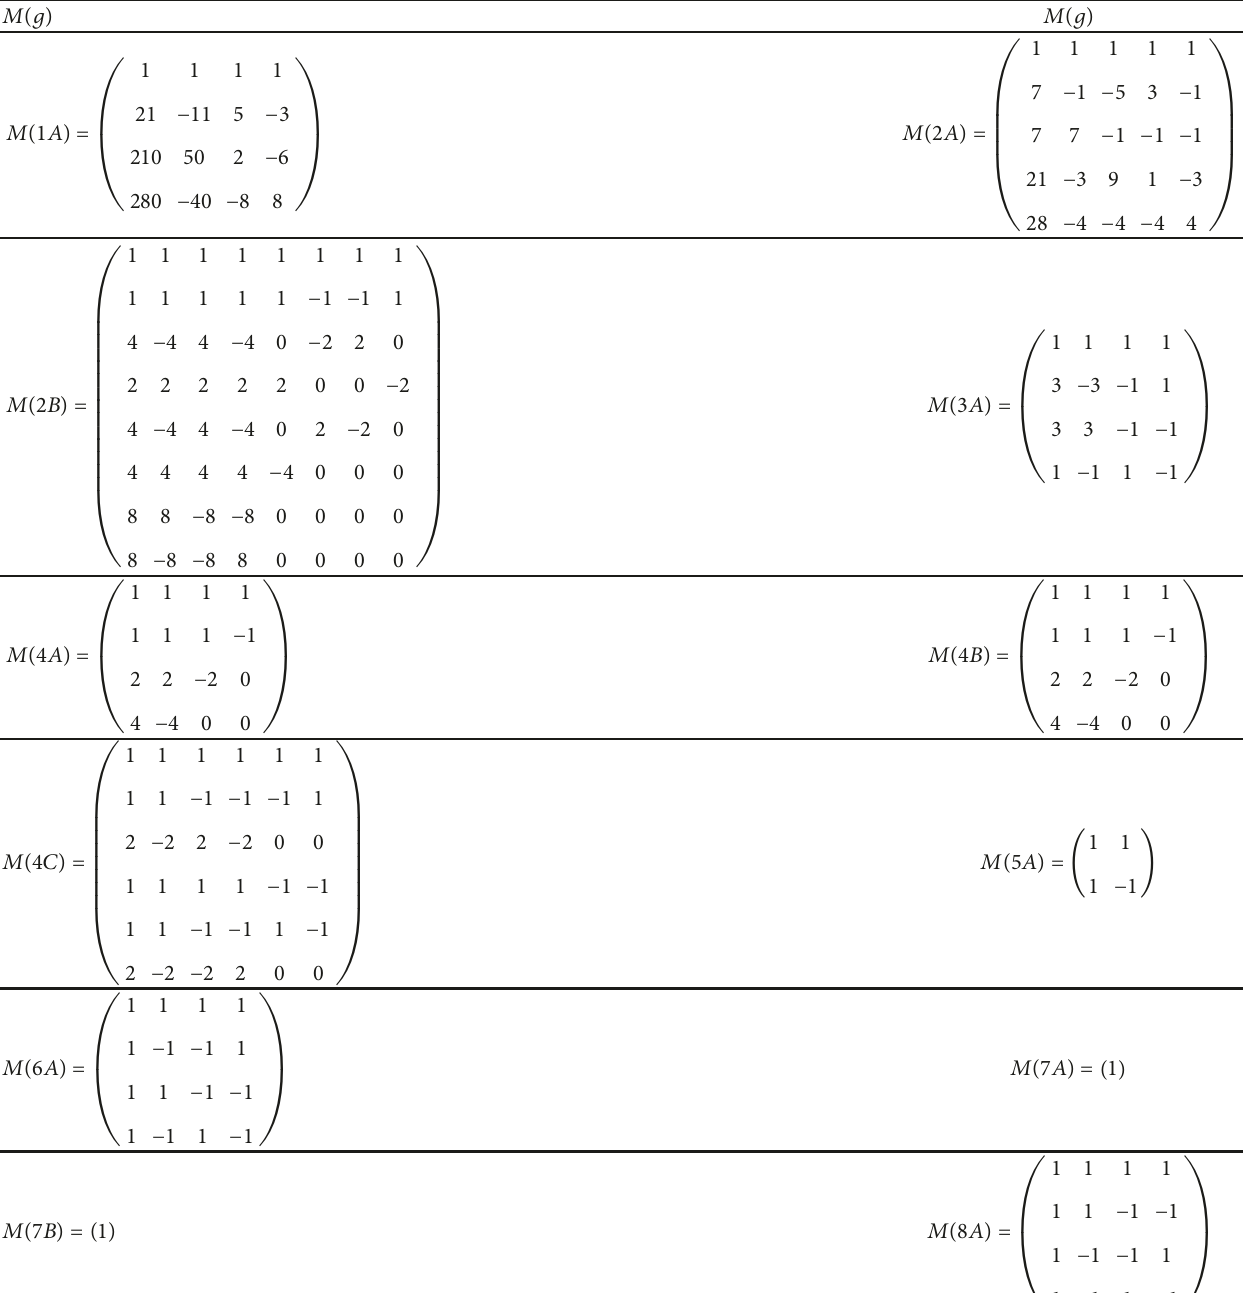
Table 6: The Fischer-Clifford matrices of 2 9 : (𝐿 3 (4) : 2)